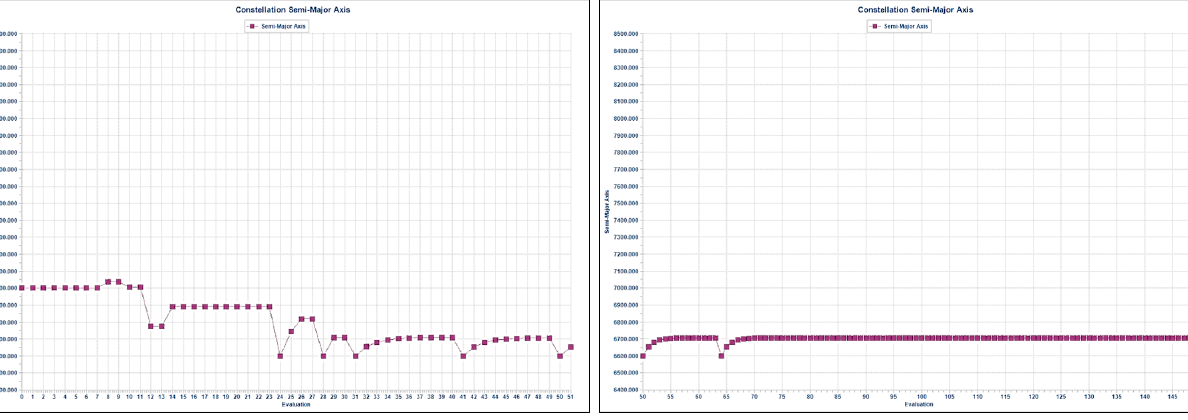
(b) Final 100 iterations Figure 18. Cost, coverage, and objective optimization process for the first 50 and later iterations. The pictorial representation of a process in obtaining an optimal solution for the con- stellations given in Figure 19 reinstates the fact that this portion of research contributes significantly to the design and orientation of the constellations using small satellites for a long-term operation in LEO region. The ipopt optimizer passed through this evaluation thoroughly as intended.